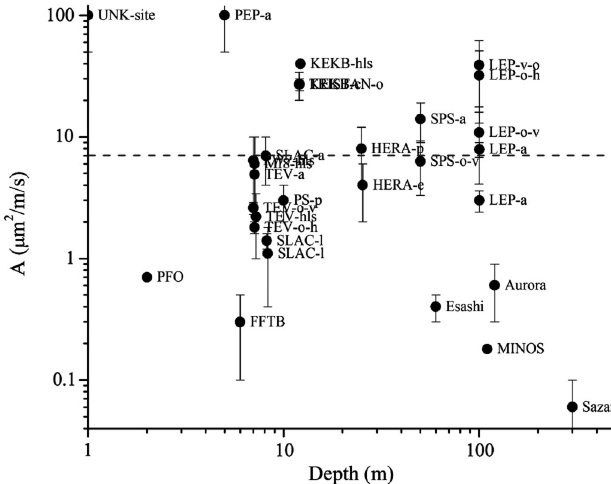
FIG. 43. Coefficients of the ground diffusion from Table I vs the depth of the observations. The dashed line represents the average value for operational